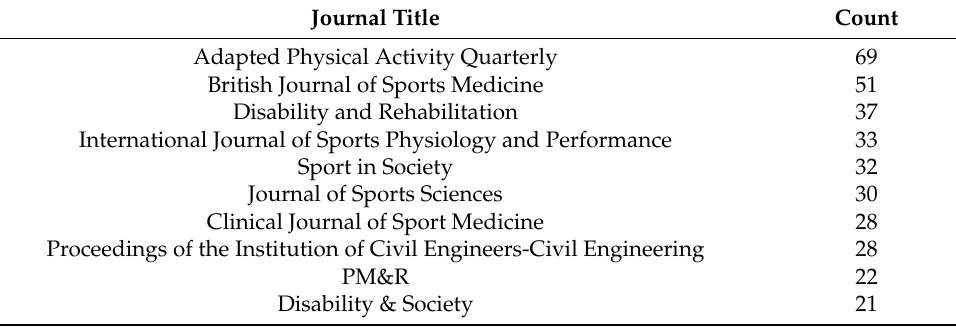
Table 3. The top 10 journals that published articles on adapted sport